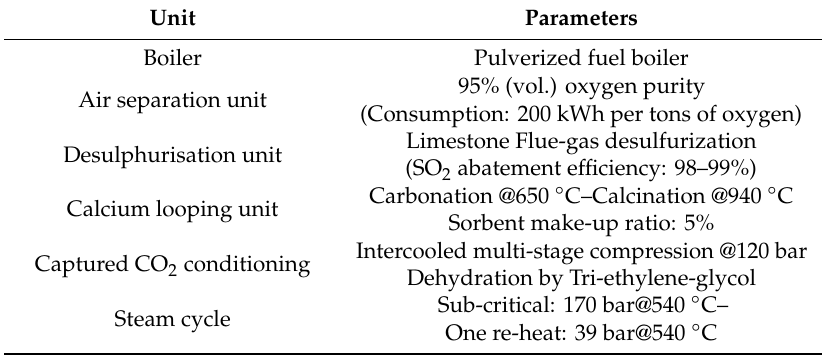
Table 1. Main design characteristics of the power plant and of the CaL unit (adapted from [4]).